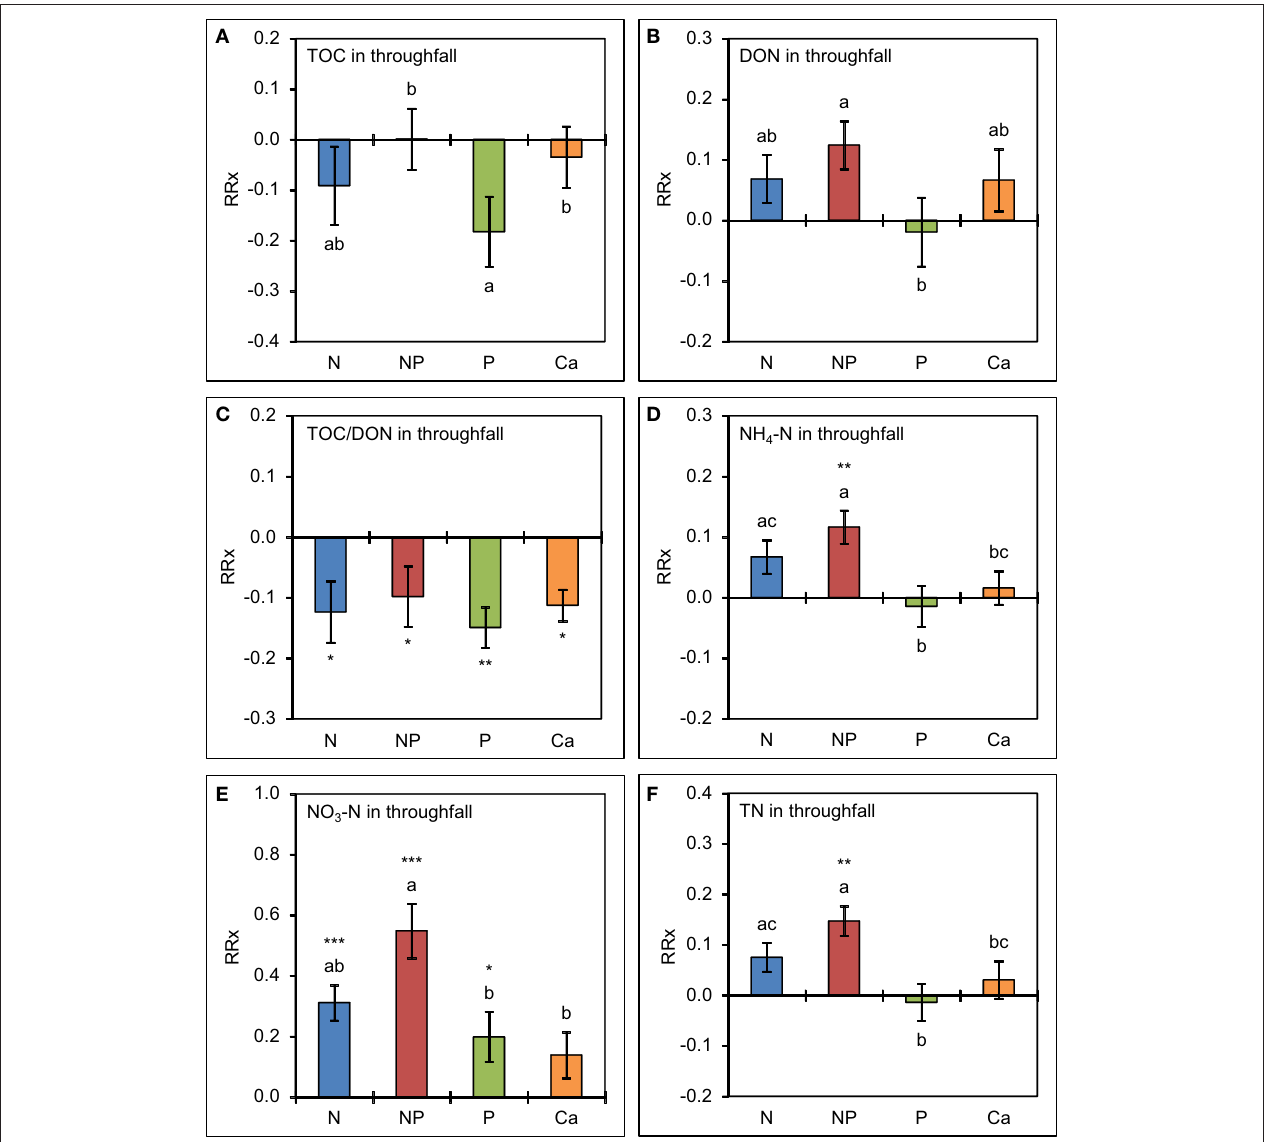
FIGURE 4 | Cumulative effects of nutrient manipulations observed in throughfall after 5 years of nutrient additions. The diagrams show the average responses over 5 years of (A) total organic carbon (TOC) concentrations, (B) dissolved organic nitrogen (DON) concentrations, (C) TOC/DON ratios, (D) ammonium-N (NH 4 -N) concentrations, (E) nitrate-N (NO 3 -N) concentrations, and (F) total nitrogen (TN) concentrations to nutrient additions expressed as natural log-response ratios (RRx) between the respective treatments ( n = 4 ) and the unfertilized control plots ( n = 4 ). Error bars indicate plus or minus one standard error. Asterisks indicate significant differences to the control ( * p < 0.05 , ** p < 0.01 , *** p < 0.001 ). Values not sharing a common letter are significantly different from each other ( p < 0.05